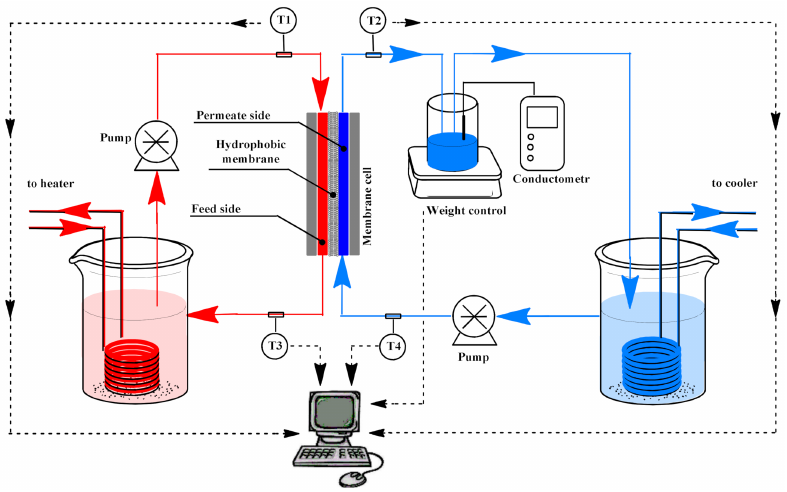
Figure 2. Scheme of membrane